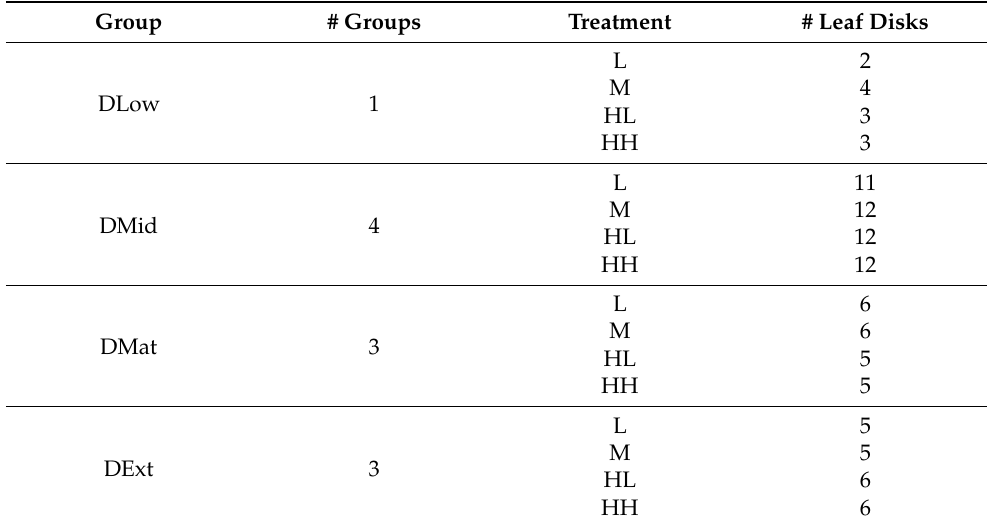
Figure 1. ( a ) Example leaves of the four decomposition groups; ( b ) litter in the incubation chamber. Table 1. Experimental treatments and samples.